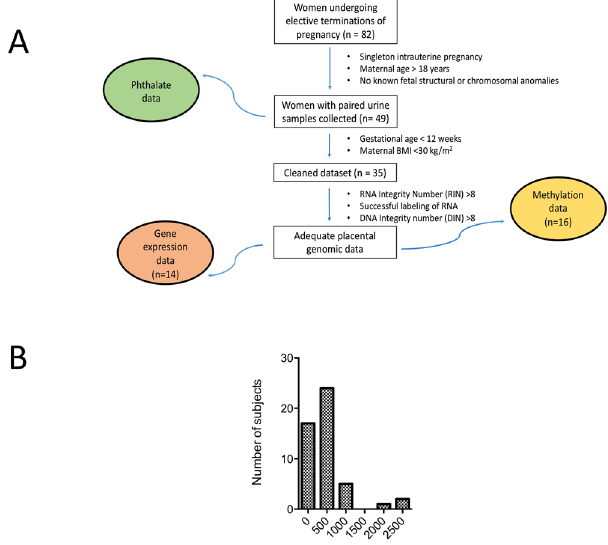
Figure 1. ( A ) Study Design. ( B ) Histogram of total phthalate urinary metabolites in study cohort.